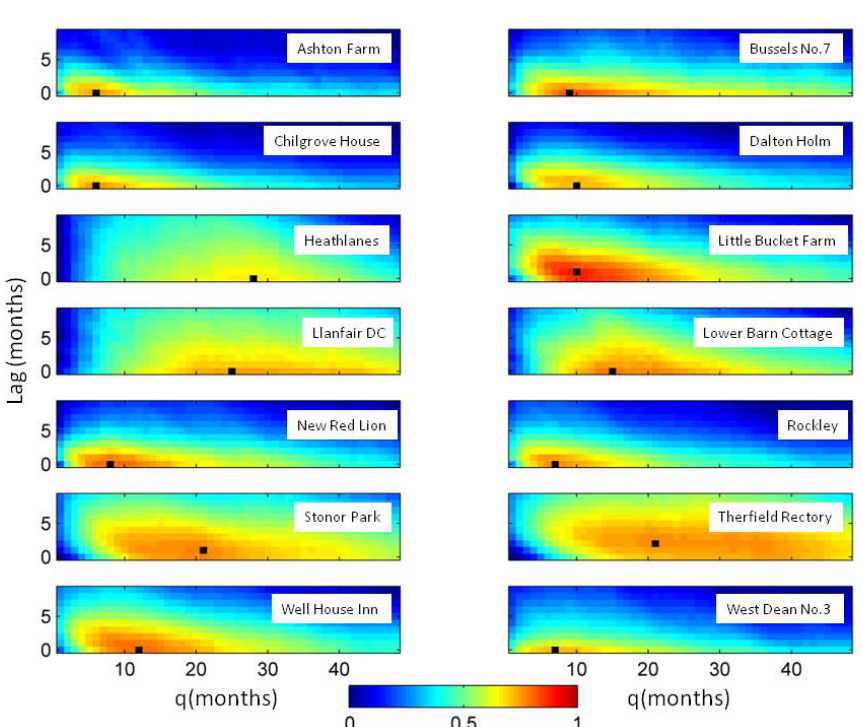
Fig. 8. Heat map of showing the variation in cross-correlation co-efficient between SGI and SPI as a function of SPI precipitation accumu- lation period, q , and lag between SGI and SPI time series. The maximum correlation for each accumulation period is highlighted (black